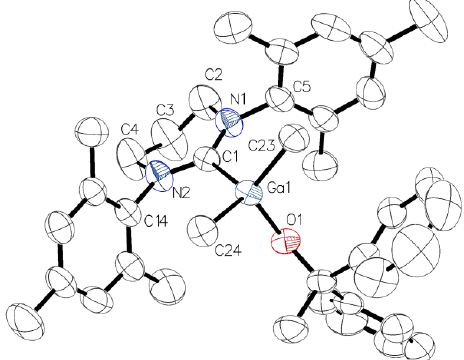
Figure 3. Molecular structure of 3 with thermal ellipsoids at 50% probability level. Selected bond lengths [Å ] and angles [°]: Ga(1)–O(1) 1.8849(12), Ga(1)–C(1) 2.1386(19), Ga(1)–C(23) 1.9879(19), Ga(1)–C(24)